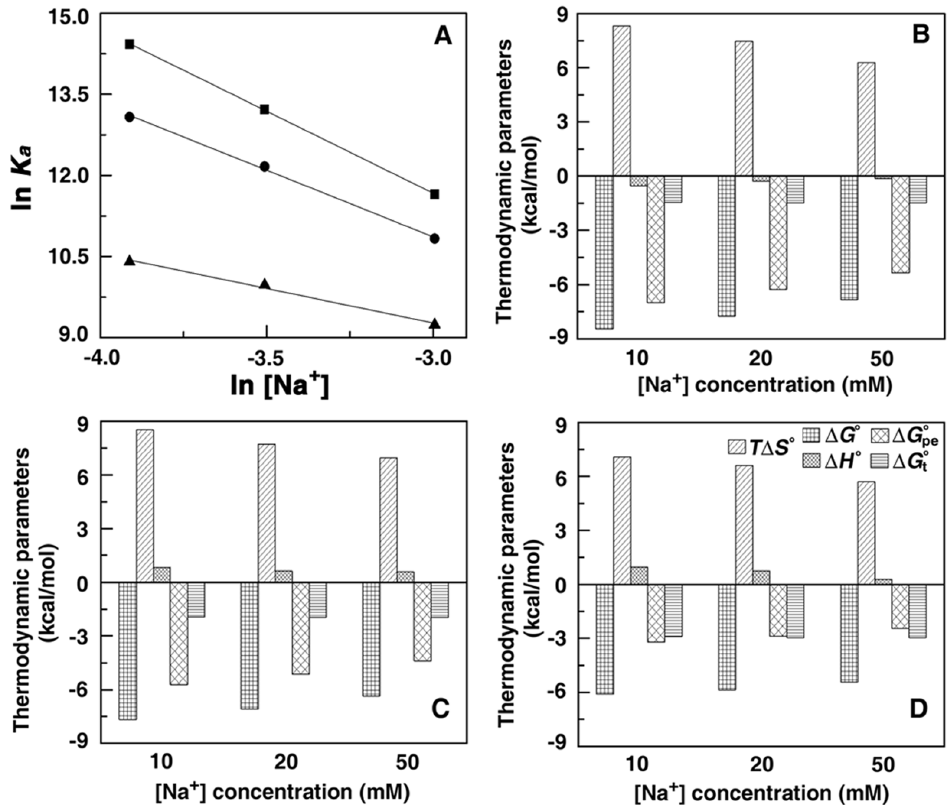
N Figure 5. Plots of variation of salt dependent thermodynamic parameters. (A) Plot of ln K a versus ln [Na + ] for the binding of spermine with ), MLDNA ( m ). Bar diagram describing the variation of magnitude of thermodynamics parameters at three salt concentrations CP DNA ( & ), EC DNA ( for (B) CP DNA, (C) EC DNA and (D) ML DNA at 293.15 K.